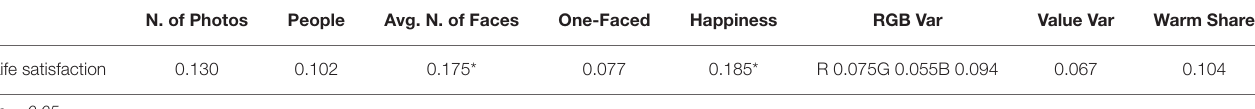
TABLE 3 | Correlations between life satisfaction and a part of high- and low-level features of Instagram photographs. N. of Photos